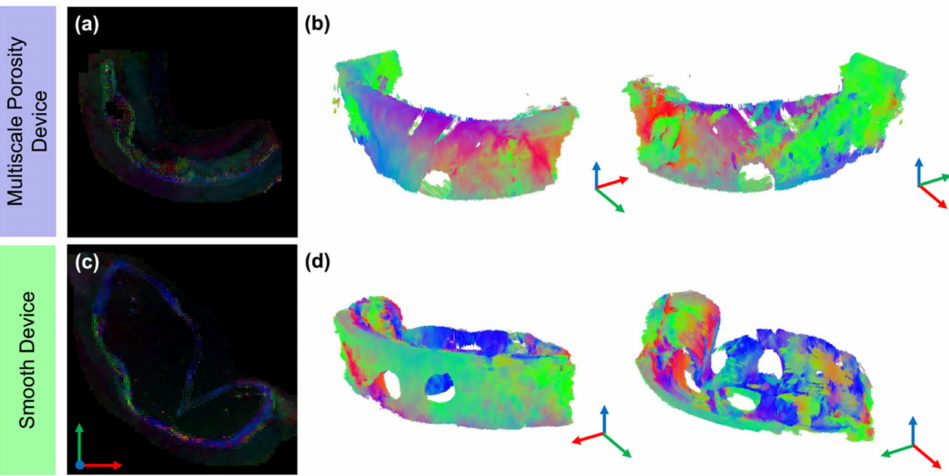
Figure 4. Vector maps and tractography for both devices. ( a , c ) First eigenvector-fractional anisotropy maps for both devices. ( b , d ) Tractography for the multiscale porosity device and smooth device, respectively. No clear delineation of a capsule is visible in the multiscale porosity device while the alignment of a capsule is clear in the smooth device. Holes are locations of biopsy punches for other analyses. Tractography was modelled with the following parameters: seed point resolution: 0.5 × 0.5 × 0.5 mm, FA threshold: 0.1, FA tracking threshold: 0.1–1, tract length: 2–20 mm, angular threshold: 30 ◦ and step size of 0.5